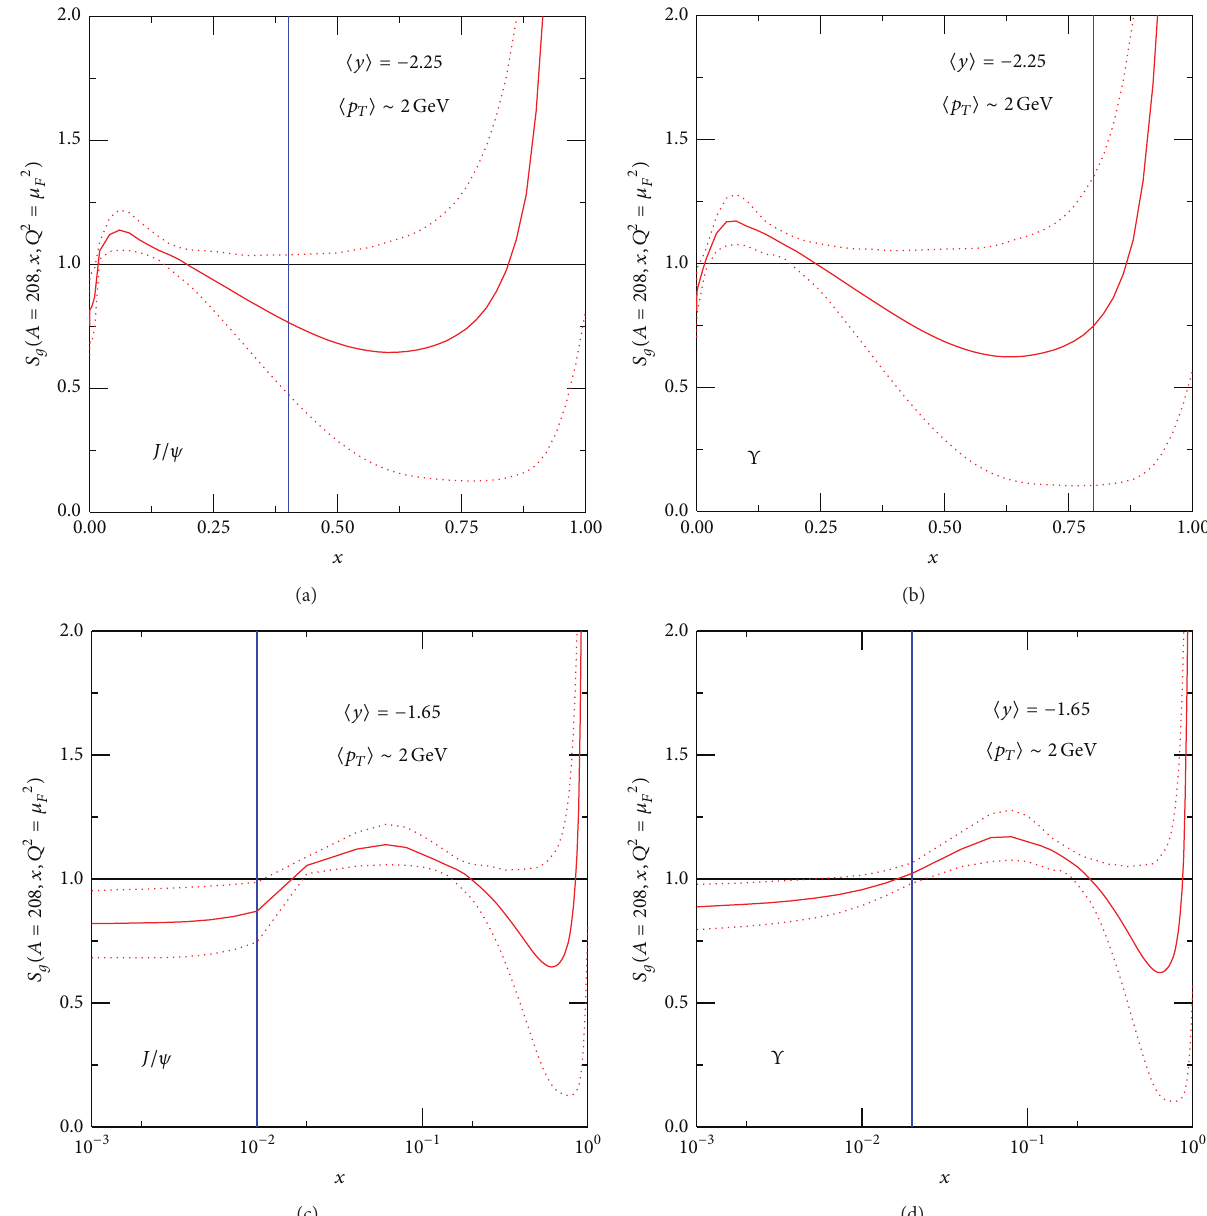
Figure 1: The EPS09 NLO shadowing ratios for 𝐽/𝜓 (a, c) and Υ(1𝑆) (b, d) production. The solid curve in each plot is the central EPS09 NLO result, while the dotted curves outline the shadowing uncertainty band. (a, b) are on a linear scale to emphasize the large 𝑥 region, while (c, d) are on a logarithmic scale to expand the low 𝑥 region. The approximate kinematic area of interest is indicated by the vertical line in each